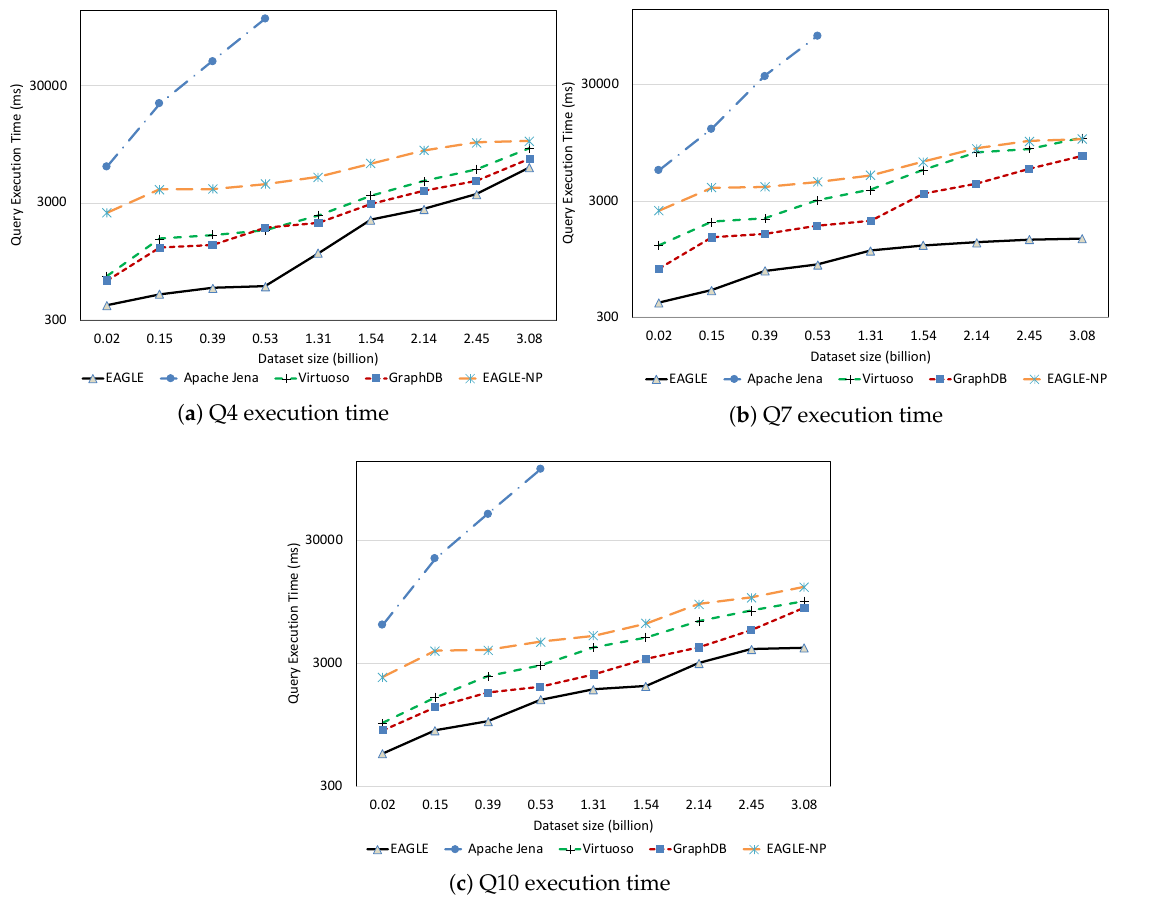
Figure 23. Mixed queries execution time with respect to dataset size (in logscale).